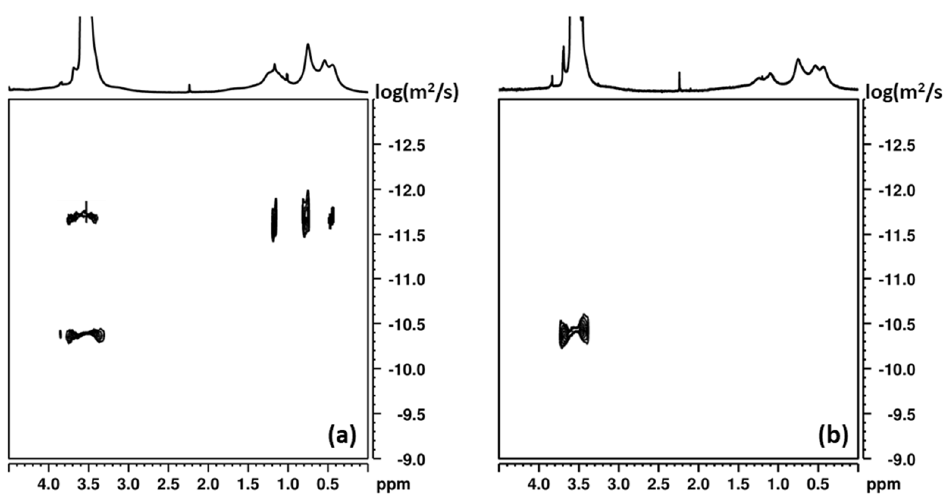
Figure 4. DOSY spectra of ( a ) OEC-III (10 mg/mL in D 2 O); ( b ) OEC-V (10 mg/mL in D 2 O). Similar behaviors, i.e., the co-existence of unimers and multimolecular aggregates in PEGylated tert